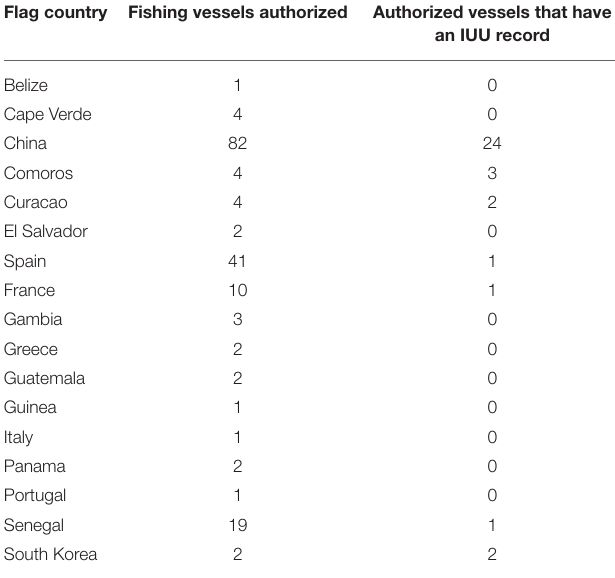
TABLE 1 | Fleet operating in Guinea Bissau by flag in 2017 and their respective offense history since